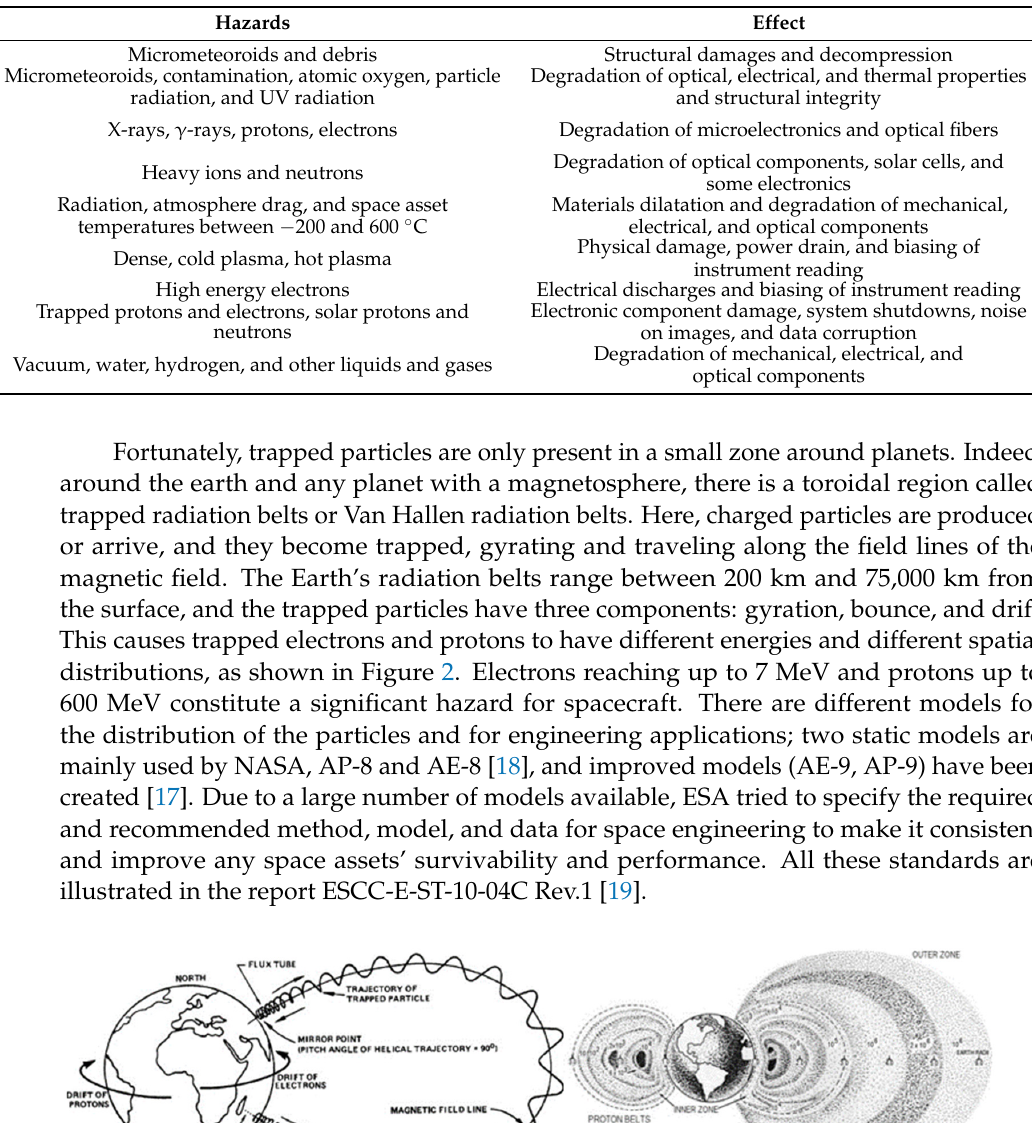
Table 1. Summary of principal space environment effects on space hardware [11,16,17].